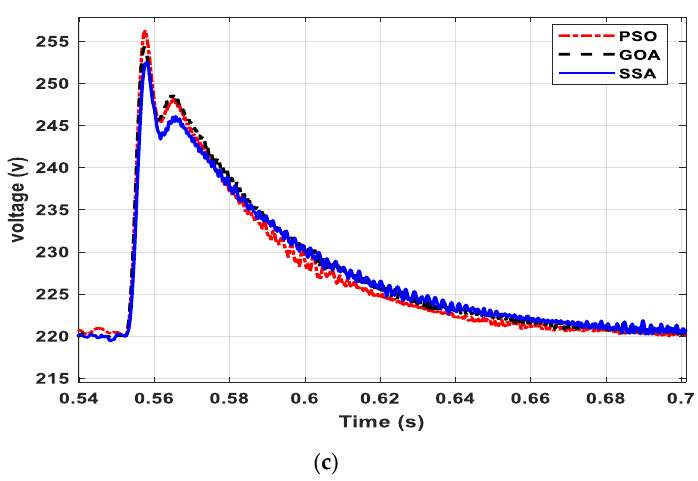
Figure 7. Voltage profile at ( a ) DG insertion ( b ) abrupt Load increment ( c ) abrupt load decrement.